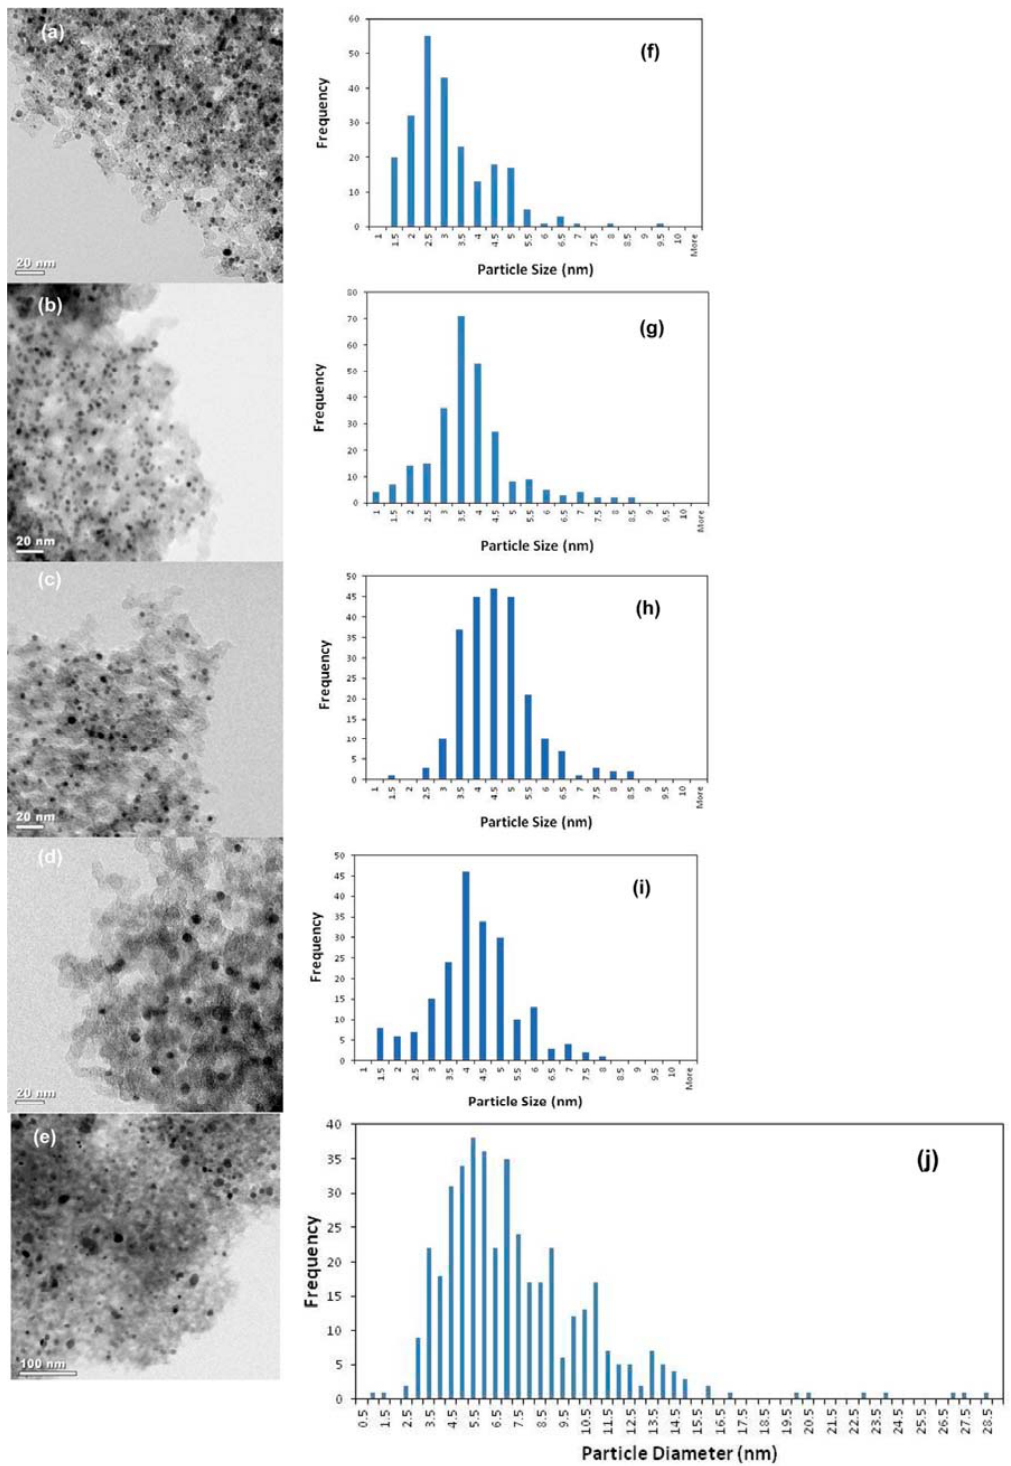
Figure 9. TEM images and particle size distributions of carbon aerogel supported Pt–Cu BMNPs